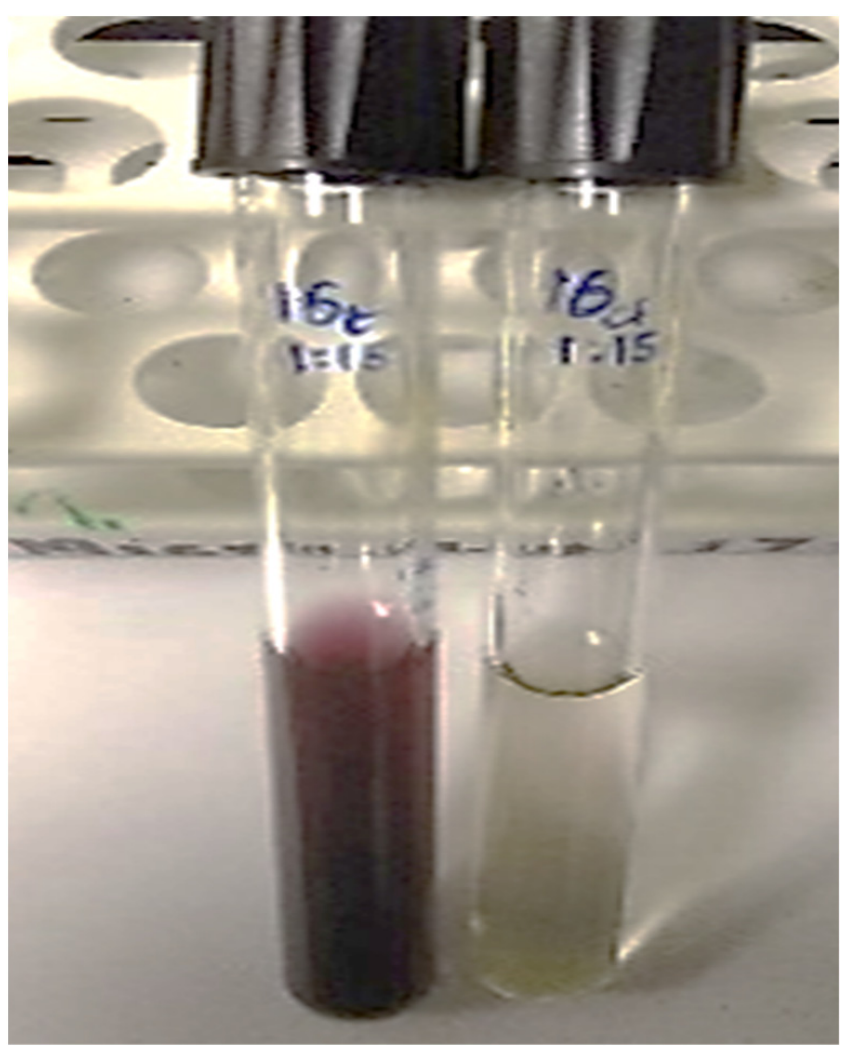
Figure 2. Initial confirmation of synthesis of AuNPs by a visible color change.